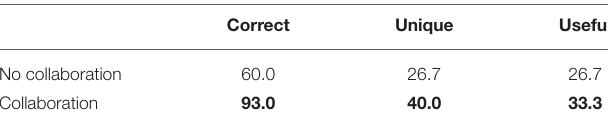
The bold value indicates the largest values per